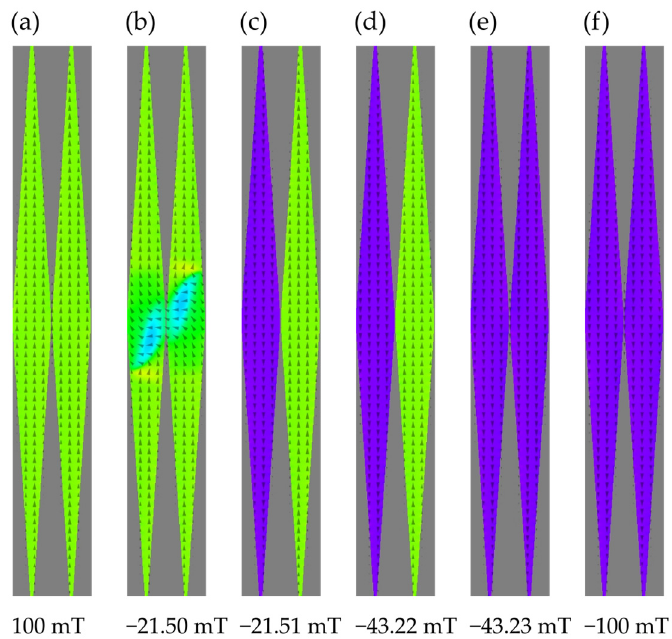
Figure 8. Magnetization maps for a pair of macrospins at the separation distance d = 10 nm. ( a ) saturated FM configuration, ( b , c ) just before and just after the FM → AF switching, ( d , e ) just before and just after the AF → rFM, ( f ) saturated rFM configuration.